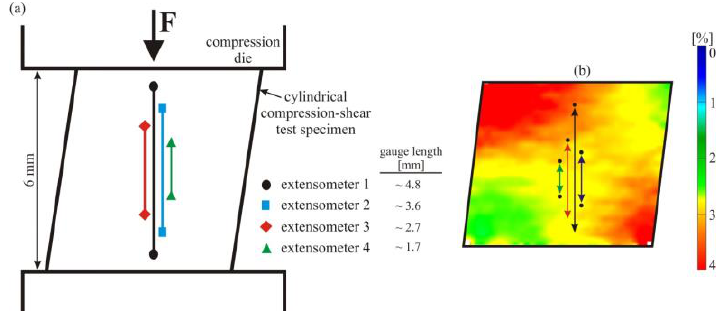
Figure 7. ( a ) Schematic representation of the cylindrical specimen with an inclination angle for compression-shear testing; ( b ) axial surface strain field image measured at the end of compression-shear loading (prior to unloading). Four virtual extensometers that are located here next to each other for a better overview were investigated under compression-shear loading, where the strain fields